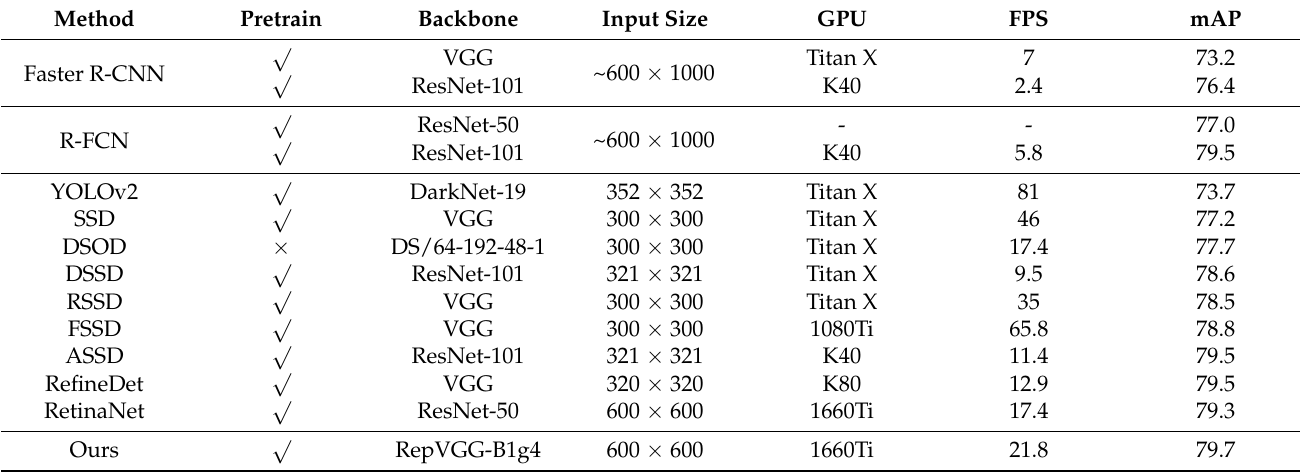
Table 2. Comparison of the test detection results on PASCAL VOC2007. The detection speed is measured by FPS with a single 1660Ti GPU using a batch size of 1.